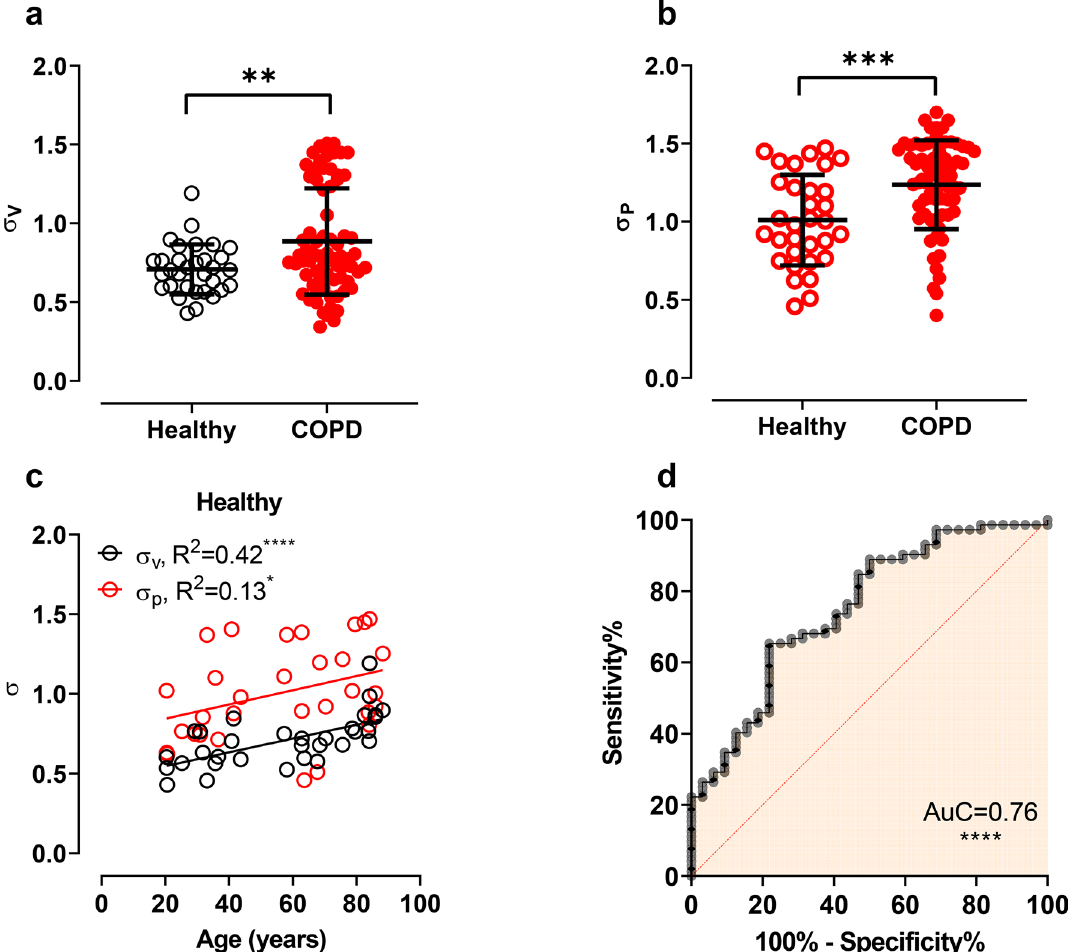
Figure 3. The IST heterogeneity indices in human data. Panels ( a ) and ( b ) show unpaired Student’s t test of the IST ventilation ( σ V ) and perfusion heterogeneity ( σ P ) indices. Panel ( c ) shows the linear regression of the IST heterogeneity indices versus ages in healthy people. Panel ( d ) shows the receiver operating characteristic curve of the COPD classification using only IST heterogeneity indices. * p < 0.05; ** p < 0.01; *** p < 0.001; **** p < 0.0001.